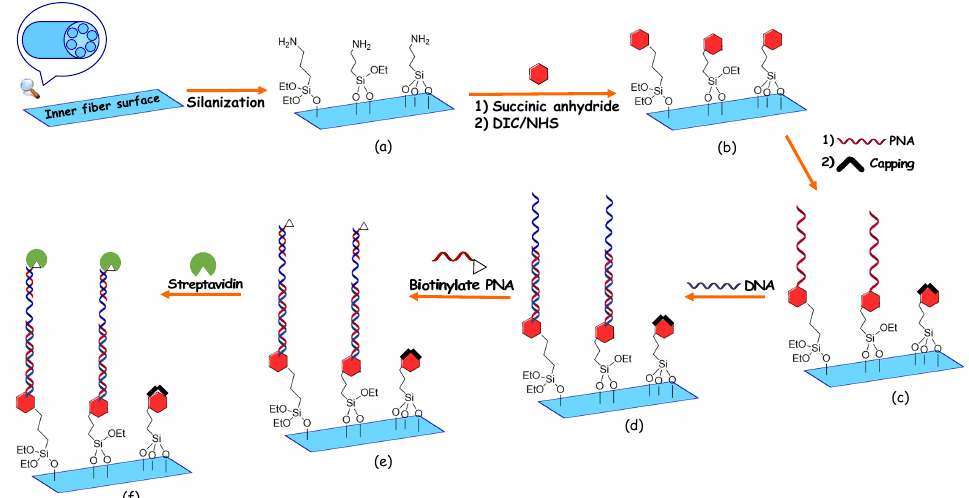
Figure 3. Derivatization scheme used for the HC-TLF: ( a – c ): derivatization; ( d – f ) DNA detection.